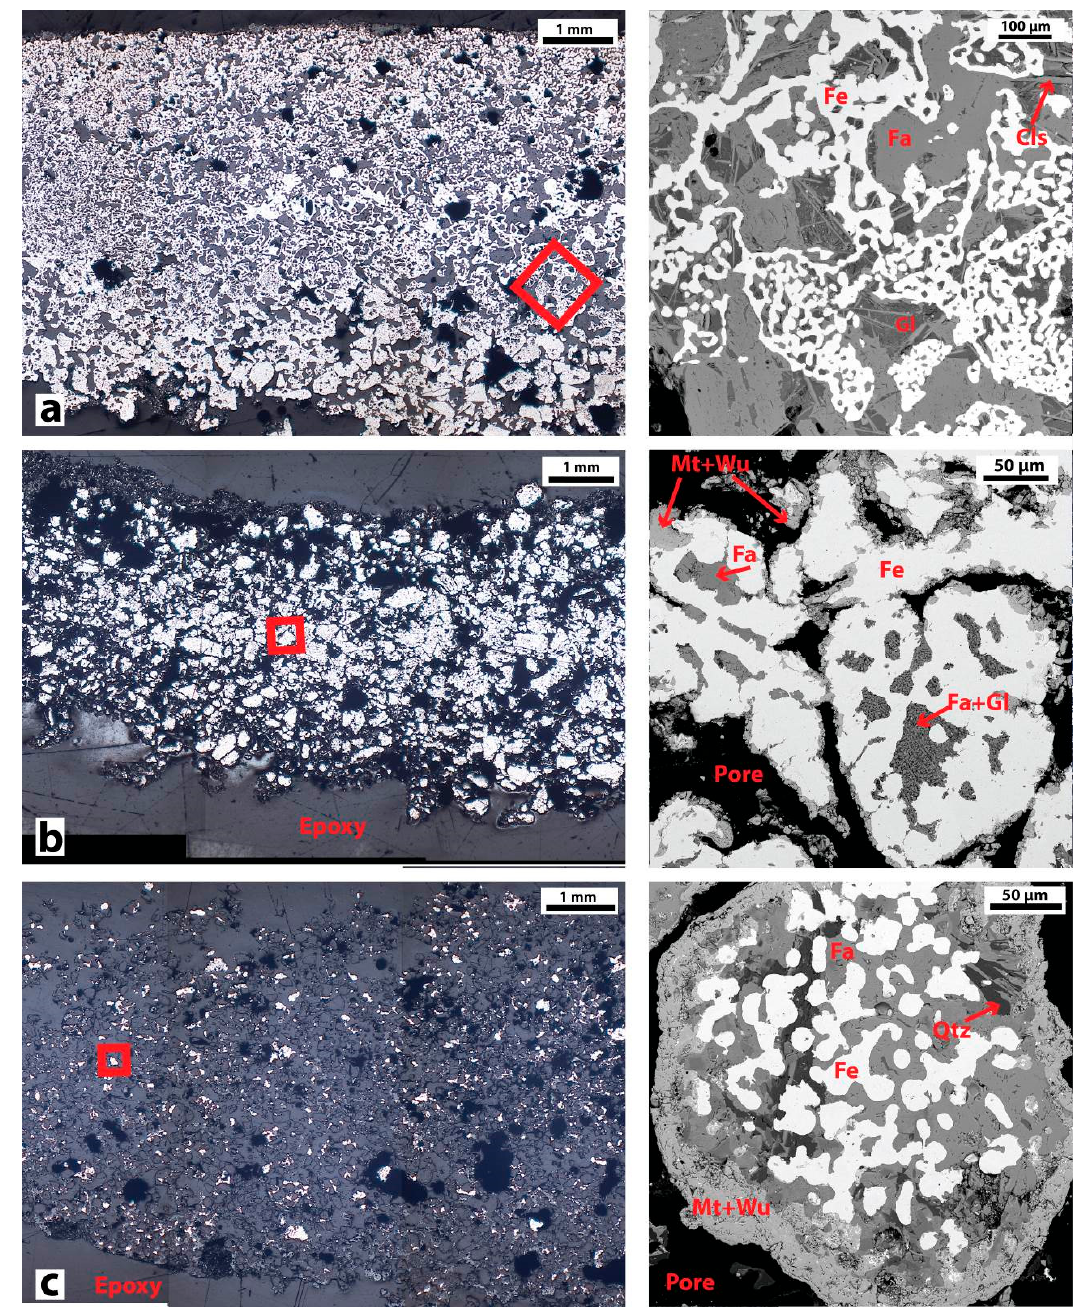
Figure 6. Typical microstructures of W CB , M CB , and P CB . Left: Optical microscopy overview image of bloom cross-section. Right: SEM-BEI. Magnified area of the red rectangle on the Left ( a ) Negev-6. W CB . Dense mass consisting of metallic iron (Fe) network and interstitial areas occupied by newly formed silicate slag. The slag is composed of massive crystals fayalite (Fa), needles of celsian (Cls) and glass (Gl); ( b ) Negev-4. M CB . Porous mass consisting of loosely interconnected metal particles and slag restricted to intermetallic grains. The slag is heterogeneous; some areas have microlitic texture consisting of fayalite and glass; other areas are only composed of fayalite. The exterior of metal grains is composed of wustite-magnetite ex-solutions (Wu + Mt). ( c ) Arabah-2. P CB -1. Poorly sintered, highly porous mass, in which only individual metal grains (such as the one on the Right ) were reduced. Slag is composed of fayalite, and unreacted quartz (Qtz). The exterior parts of reduced metallic grains are composed of wustite-magnetite ex-solutions.